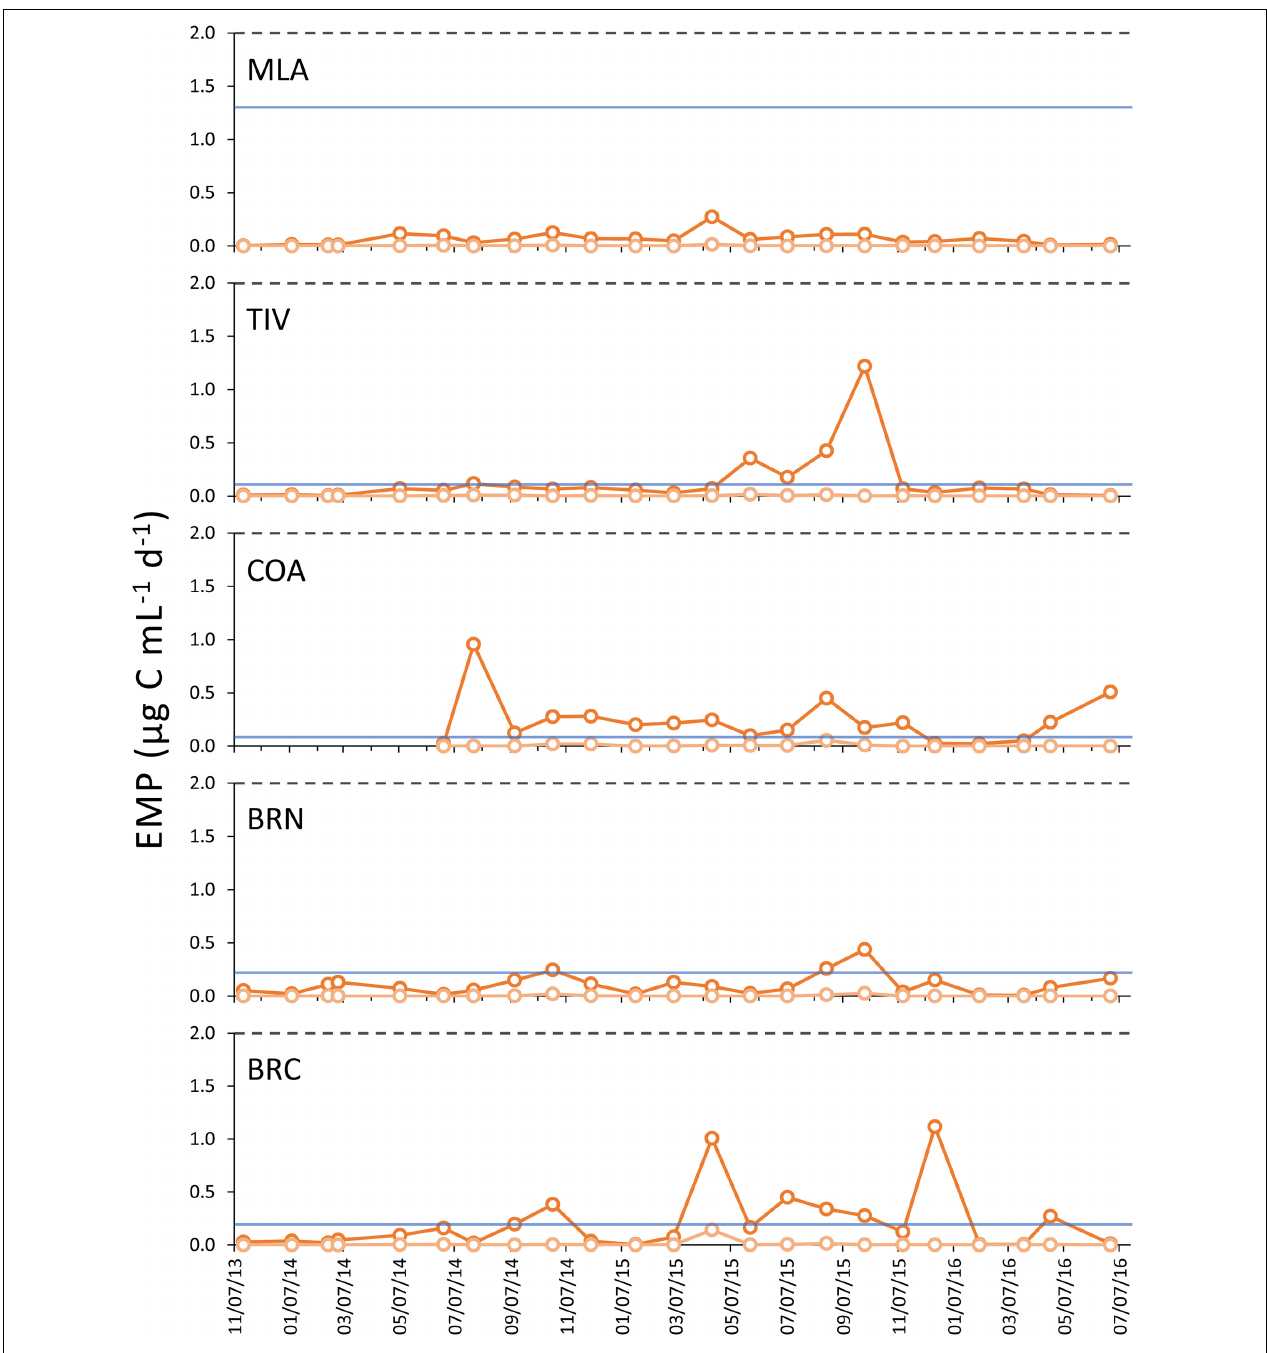
FIGURE 3 | Estimated Metagrazing Potential maxima (EMP max , dark orange lines) and minima (EMP min , pale orange lines) for the suite of key mesozooplankton grazers across all five monitoring sites. To aid comparisons between grazing potential and phytoplankton biomass, the phytoplankton bloom threshold (2 µ g C mL − 1 , gray dashed lines) and the minimum phytoplankton biomass recorded at each site (blue solid lines), are denoted.